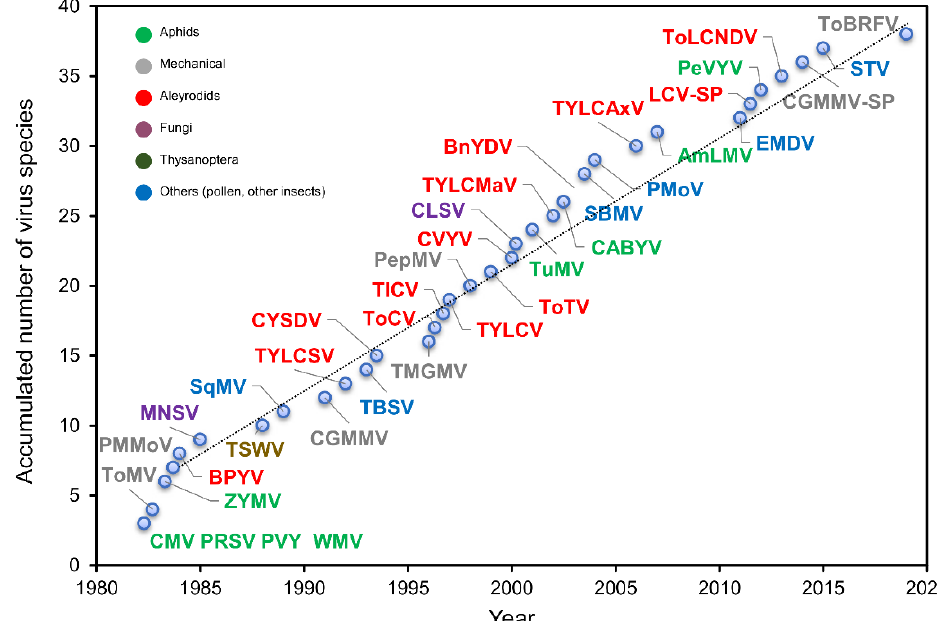
Figure 2. Timeline of accumulated virus occurrences in the Mediterranean Arc of Spain. Virus acronyms: AmLMV (Amaranthus leaf mottle virus), BnYDV (bean yellow disorder virus), BPYV (beet pseudo-yellows virus), CABYV (cucurbit aphid-borne yellows virus), CGMMV (cucumber green mottle mosaic virus), CLSV (cucumber leaf spot virus), CMV (cucumber mosaic virus), CVYV (cucumber vein yellowing virus), CYSDV (cucurbit yellowing stunting disorder virus), EMDV (eggplant mottled dwarf virus), LCV-SP (lettuce chlorosis virus), MNSV (melon necrotic spot virus), PepMV (pepino mosaic virus), PMMoV (pepper mild mottle virus), PMoV (parietaria mottle virus), PRSV (papaya ringspot virus), PVY (potato virus Y), PeVYV (pepper vein yellows virus), SBMV (Southern bean mosaic virus), SqMV (squash mosaic virus), STV (Southern tomato virus), TBSV (tomato bushy stunt virus), TICV (tomato infectious chlorosis virus), TMGMV (tobacco mild green mosaic virus), ToBRFV (tomato brown rugose fruit virus), ToCV (tomato chlorosis virus), ToLCNDV (tomato leaf curl New Delhi virus), ToMV (tomato mosaic virus), ToTV (tomato torrado virus), TSWV (tomato spotted wilt virus), TuMV (turnip mosaic virus), TYLCAxV (tomato yellow leaf curl Axarquia virus), TYLCMaV (tomato yellow leaf curl Malaga virus), TYLCSV (tomato yellow leaf curl Sardinia virus), TYLCV (tomato yellow leaf curl virus), WMV2 (watermelon mosaic virus 2), ZYMV (zucchini yellow mosaic virus). Acronyms’ colour indicates the mode of transmission. A linear regression line was calculated for virus accumulation.